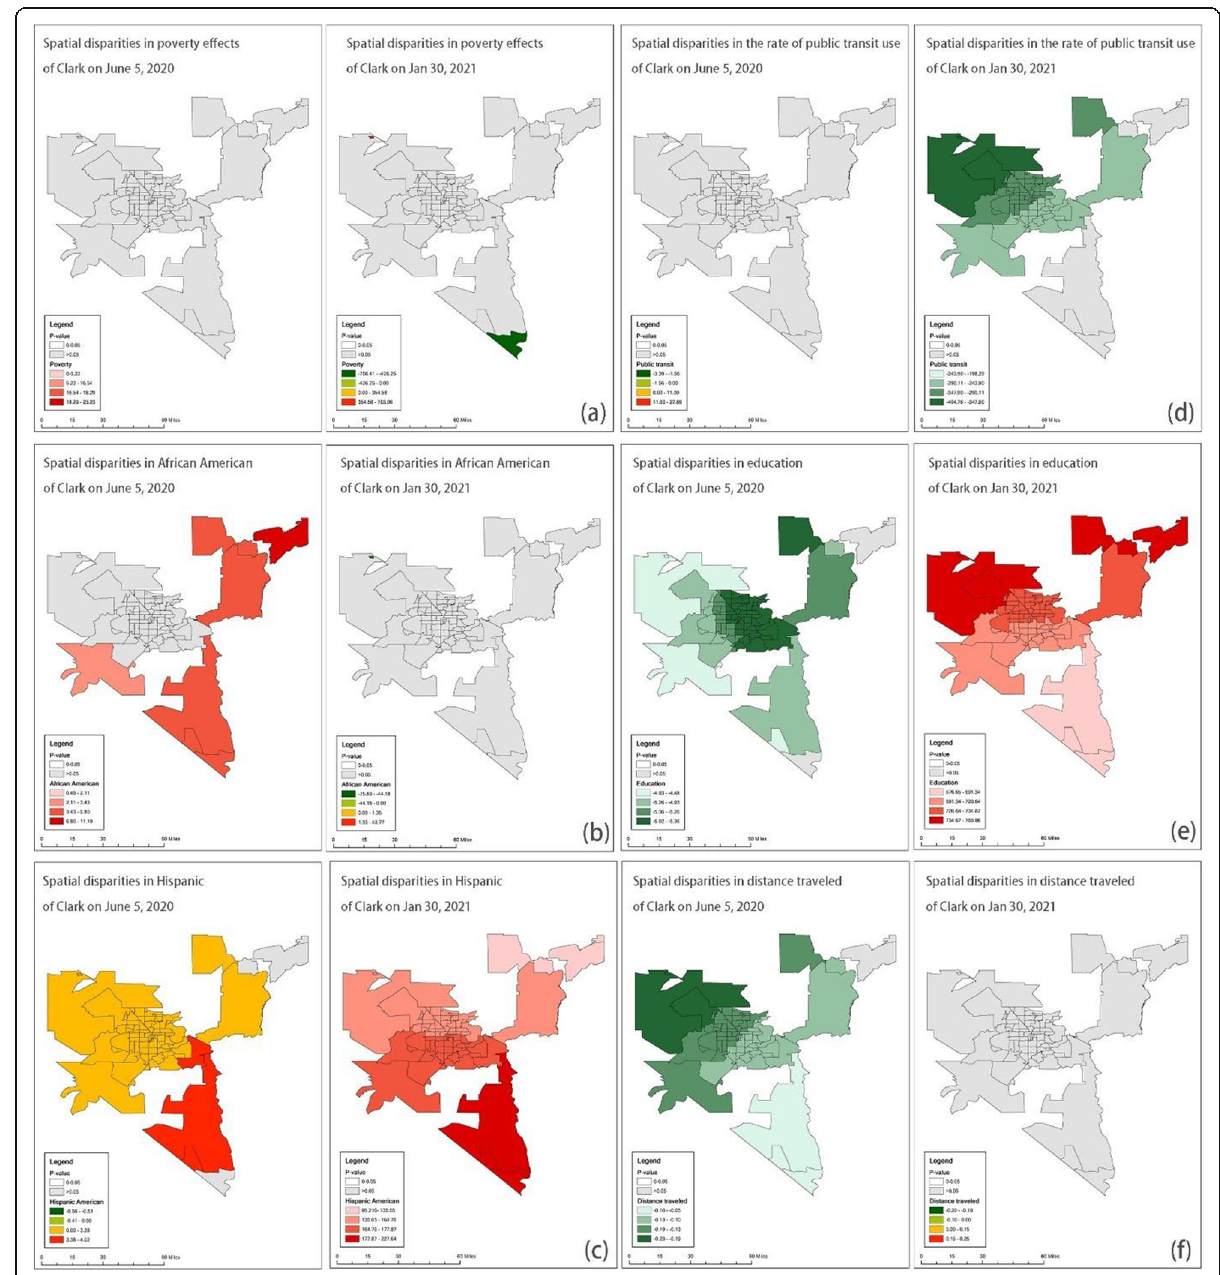
Fig. 5 GWR results for Clark County (Average R-square = 0.76 and 0.89) Note: Early-stage data is taken on June 5, 2020, and post peak is taken